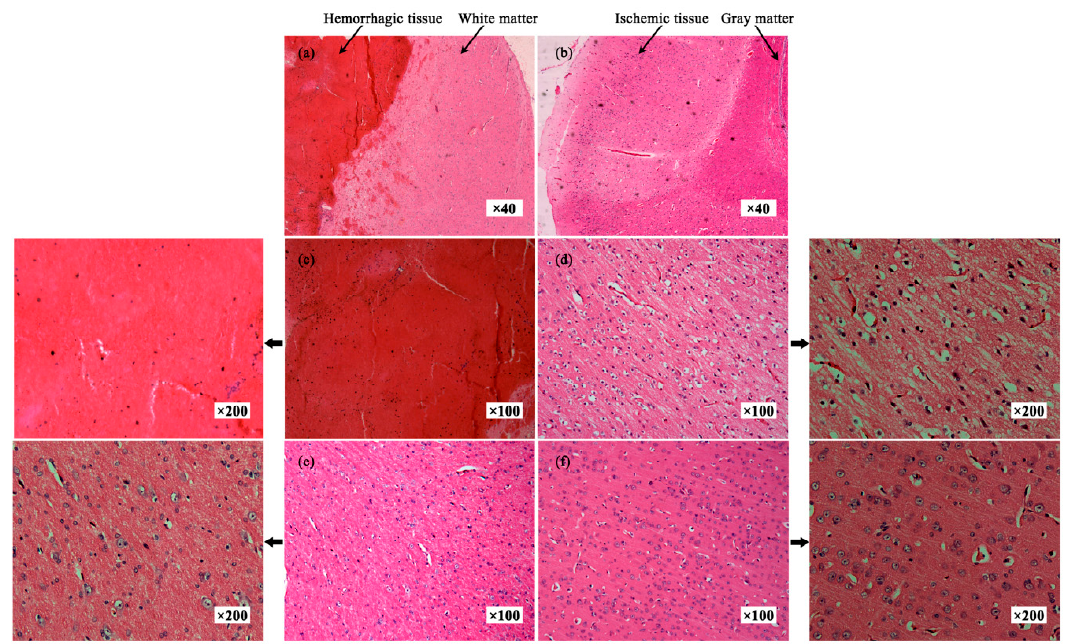
Figure 9. Hematoxylin and eosin-stained images of normal brain tissue and stroke lesions. ( a , c , e ) The hemorrhagic tissue and surrounding normal white matter and hemorrhagic tissue and white matter, respectively. ( b , d , f ) The ischemic tissue and surrounding normal gray matter and ischemic tissue and gray matter, respectively.